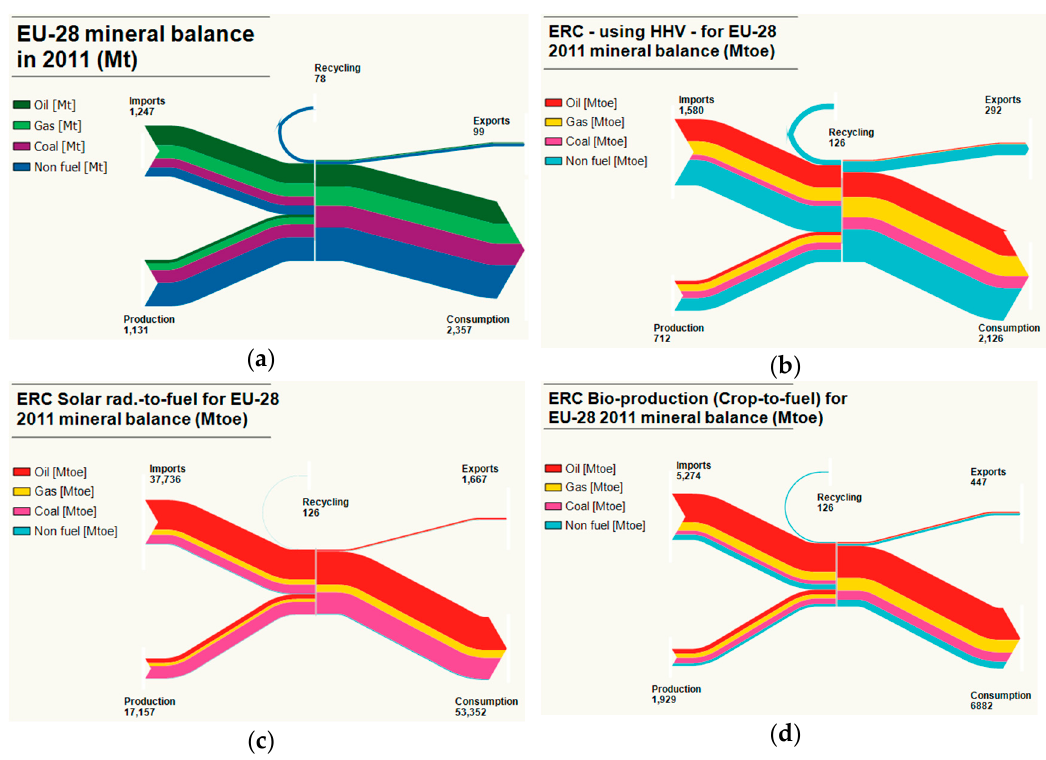
Figure 9. Mineral balance of EU-28 for 2011. Comparison between mass (Tonnes) and ERC (Mtoe) value. Note: Mass and ERC value of non-fuel minerals from [14] and fossil fuels from [80]: ( a ) Mass; ( b ) HHV; ( c ) Solar radiation to fuel; ( d ) Crop to fuel.